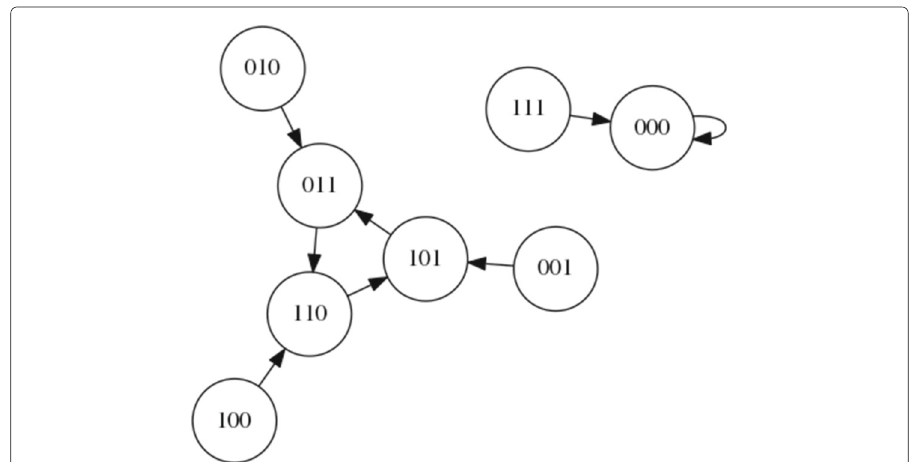
Fig. 4 State space of the simple Boolean network with all nodes using the XOR logic